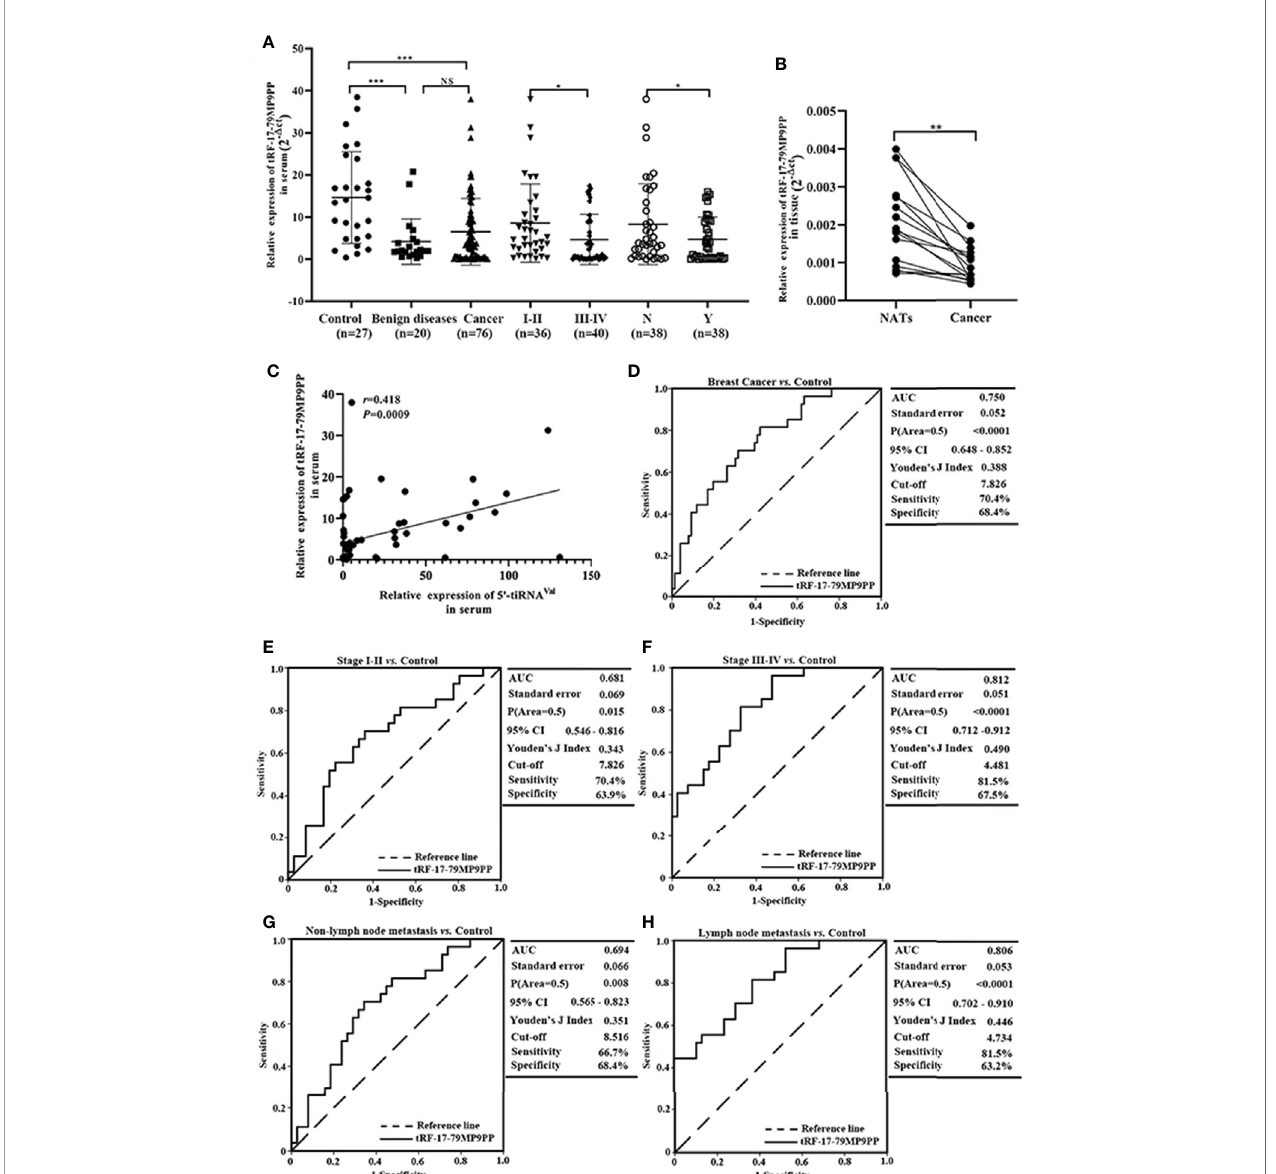
FIGURE 2 | Expression and diagnostic value of tRF-17-79MP9PP in clinical sample. (A) Scatter plot representation of tRF-17-79MP9PP levels in serum from healthy controls, benign breast diseases patients and breast cancer patients. (B) Expression of tRF-17-79MP9PP levels was quanti fi ed by qRT-PCR in tissues and NATs. (C) The correlation between 5 ’ -tiRNA Val and tRF-17-79MP9PP in serum samples was analyzed with spearman correlation test. (D) The ROC-AUC of tRF-17-79MP9PP for differentiating all breast cancer patients from healthy control. (E, F) TNM stages I – II (E) and stages III – IV (F) in breast cancer from controls. (G, H) Non-Lymph node metastasis (G) and lymph node metastasis (H) in breast cancer from controls. U6 was used normalization. * p < 0.05; ** p < 0.01, *** p < 0.001 statistically signi fi cant. NATs, non-tumor adjacent tissues; ROC-AUC, Receiver Operating Characteristic-Area Under Curve; TNM, Tumor-Node-Metastasis. NS, no signi fi